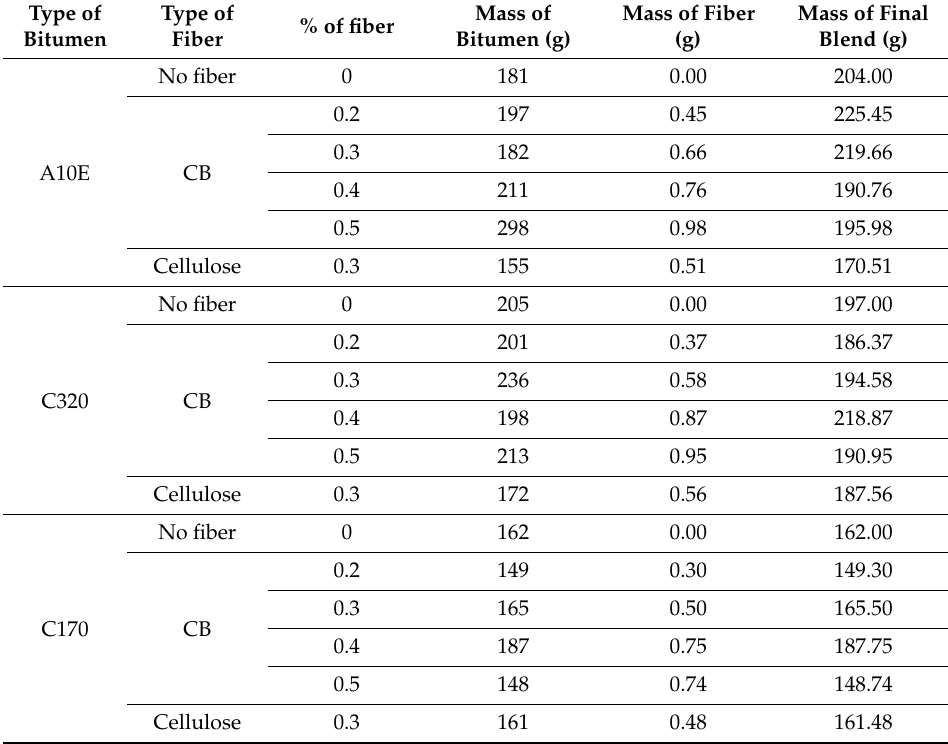
Table 4. Blending approach 3 for bitumen modified with cellulose fiber and cigarette butts.